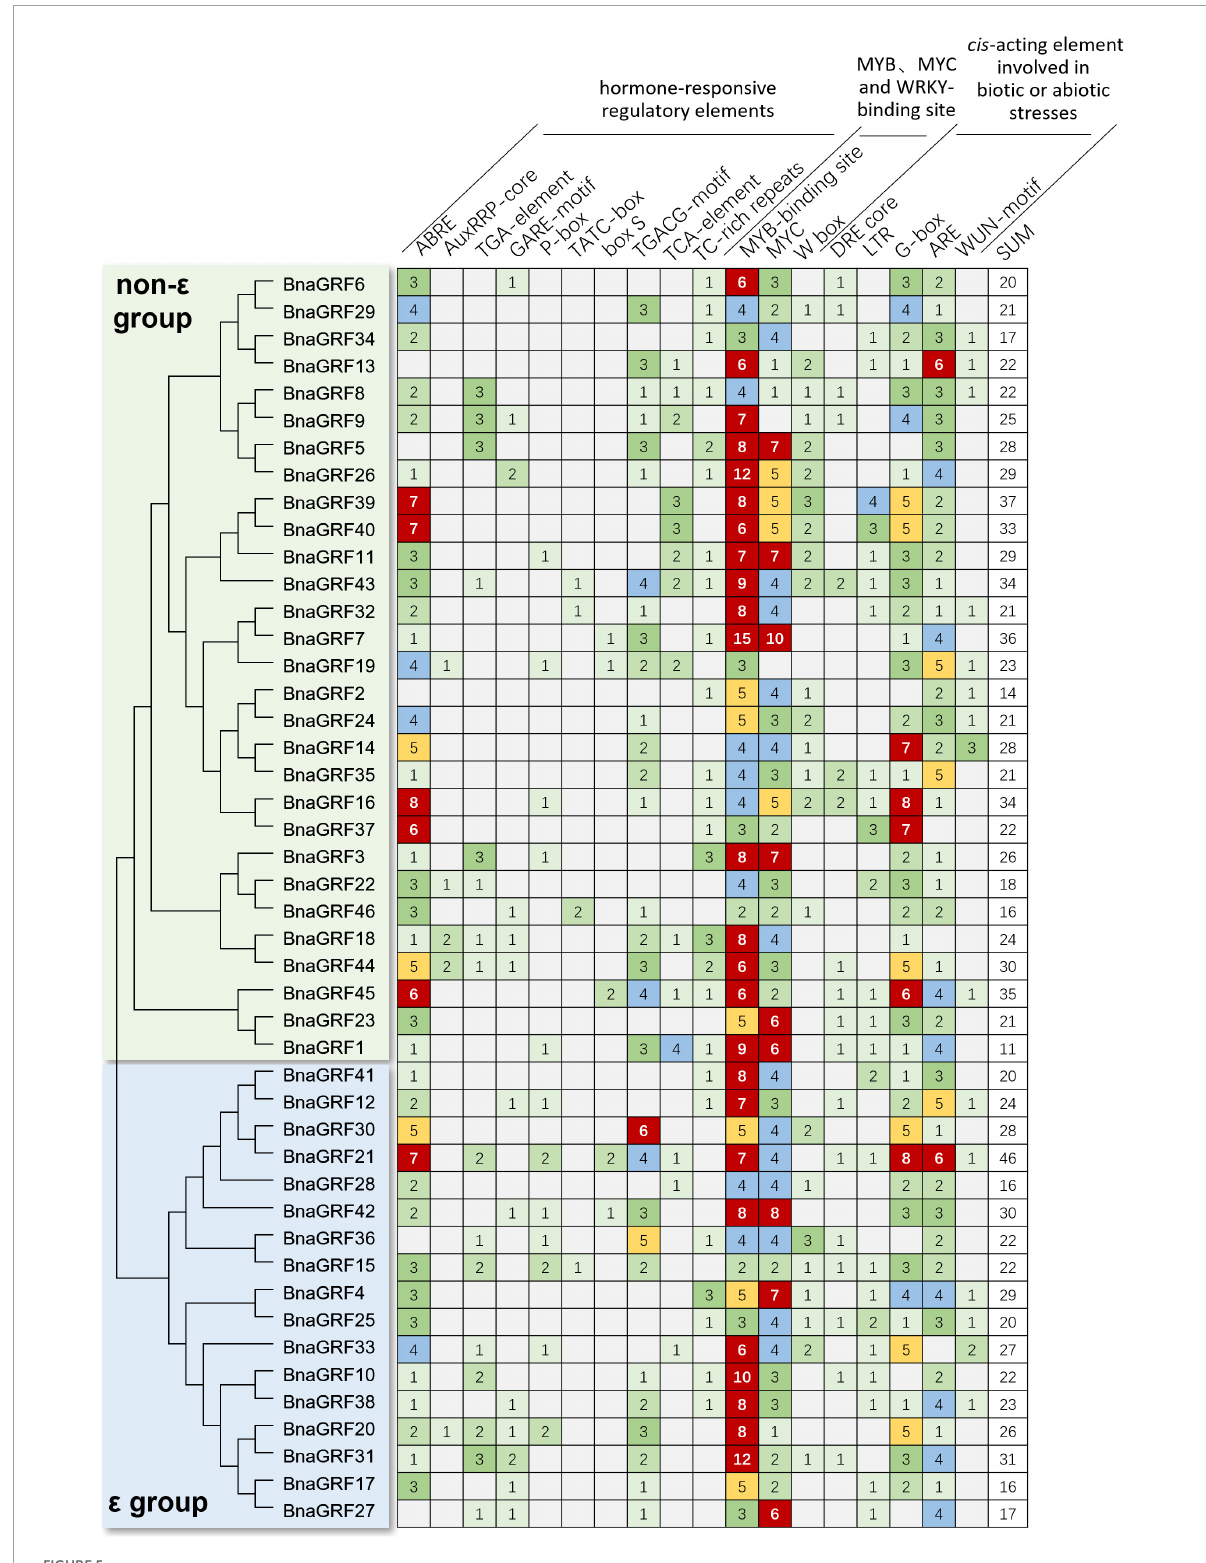
Frontiers in Plant